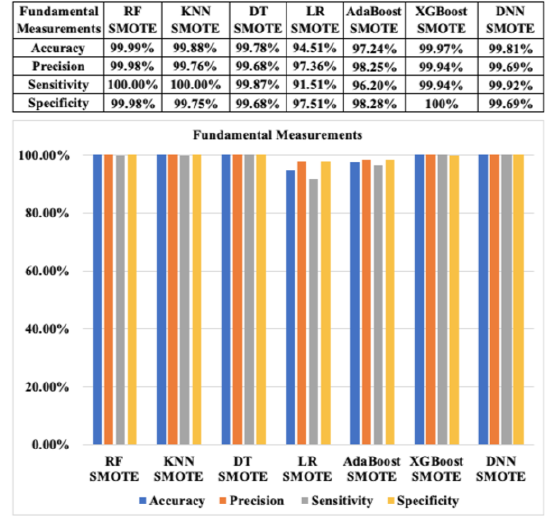
Figure 12. Fundamental classification performance measurements of ML algorithms with SMOTE based on resampling approach 1.